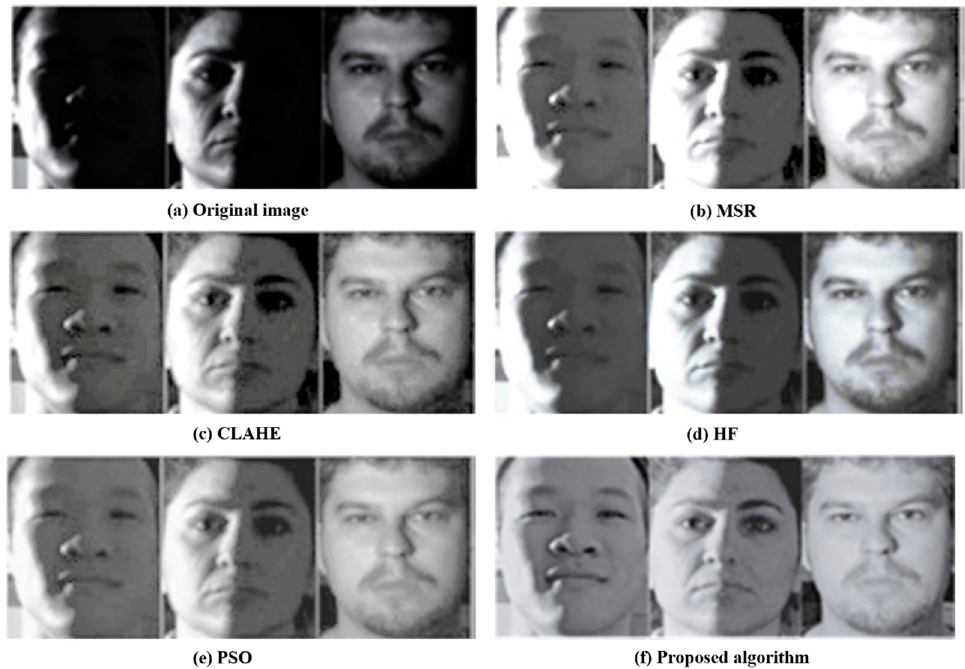
Figure 14. Comparison of the Yale face image enhancement effect.